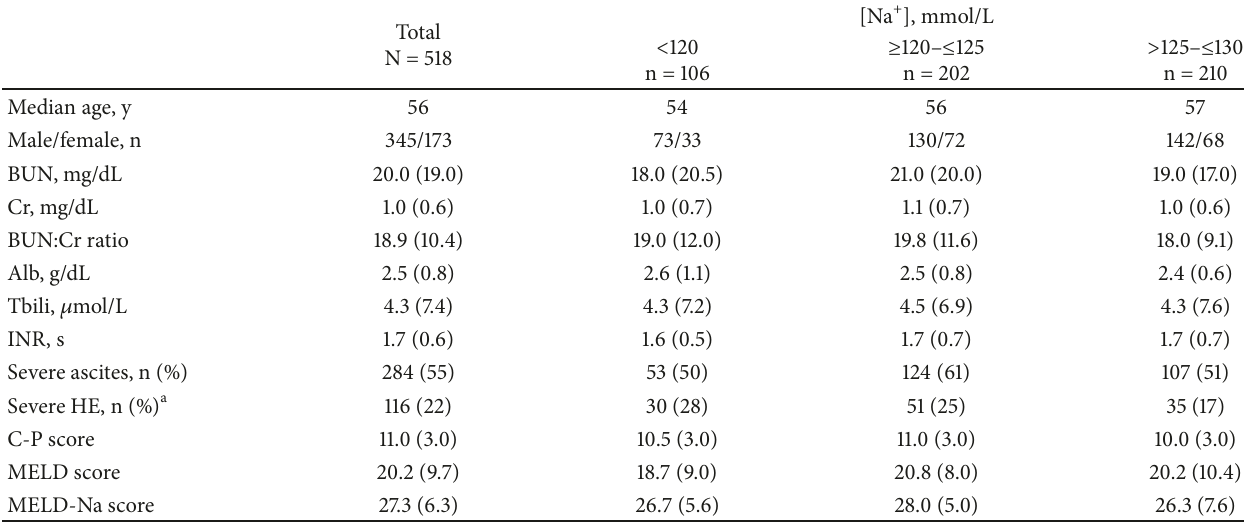
Table 2: Clinical characteristics of cirrhosis patients admitted with HN subdivided by hyponatremia